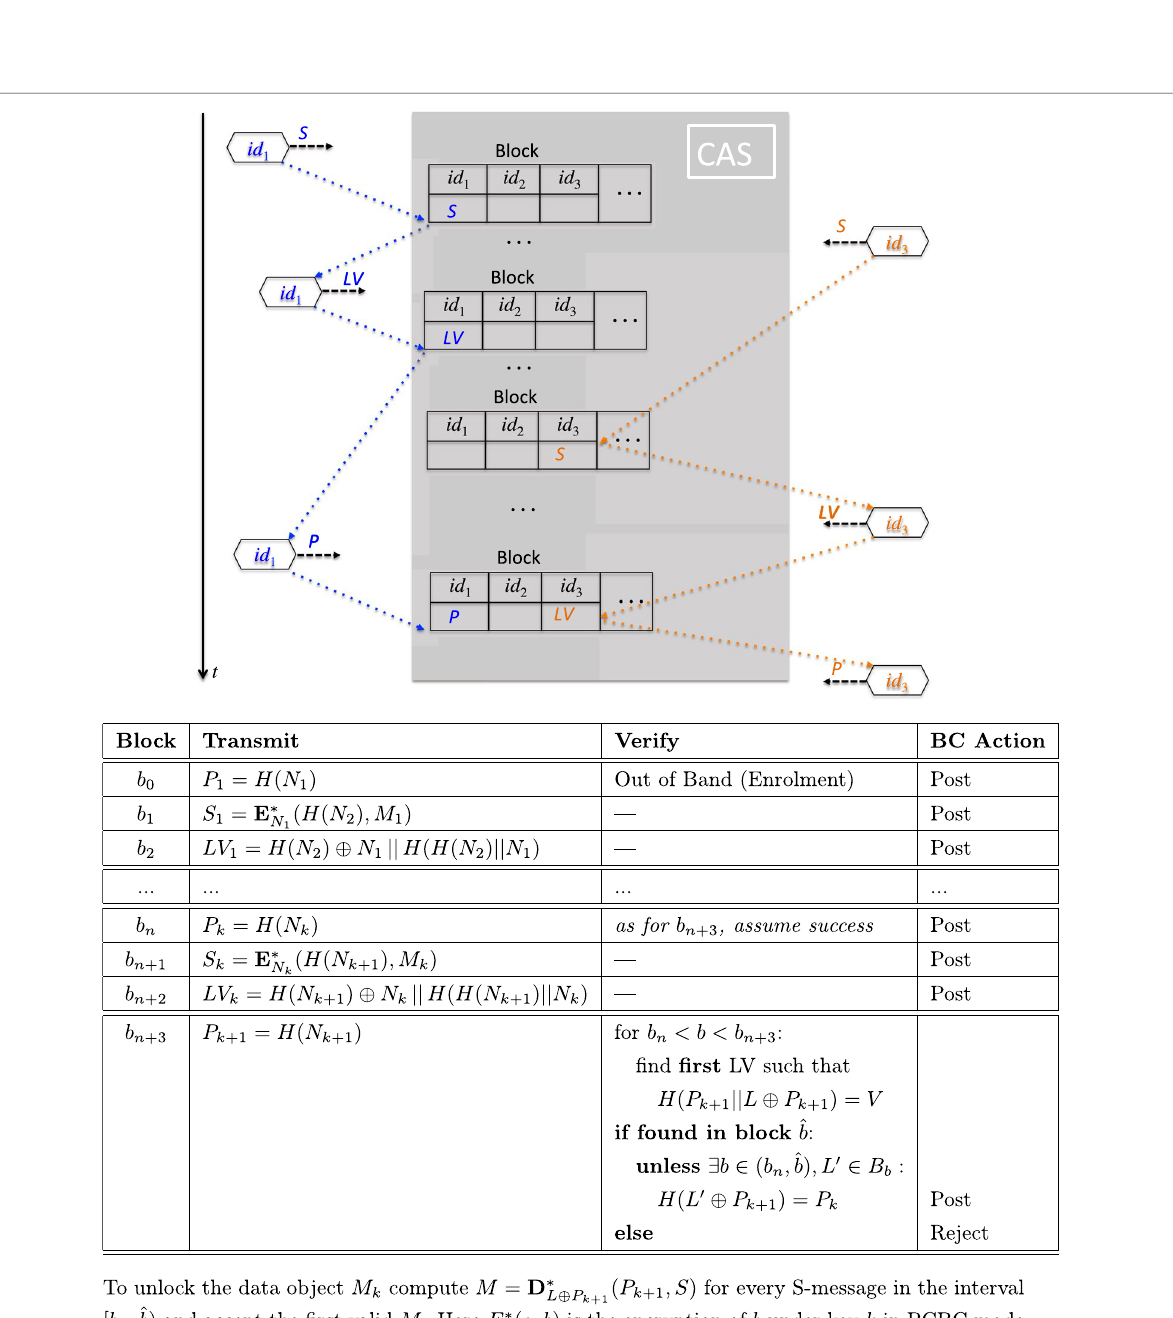
Fig. 3 Structure of the SLVP protocol. Table on behalf of a single